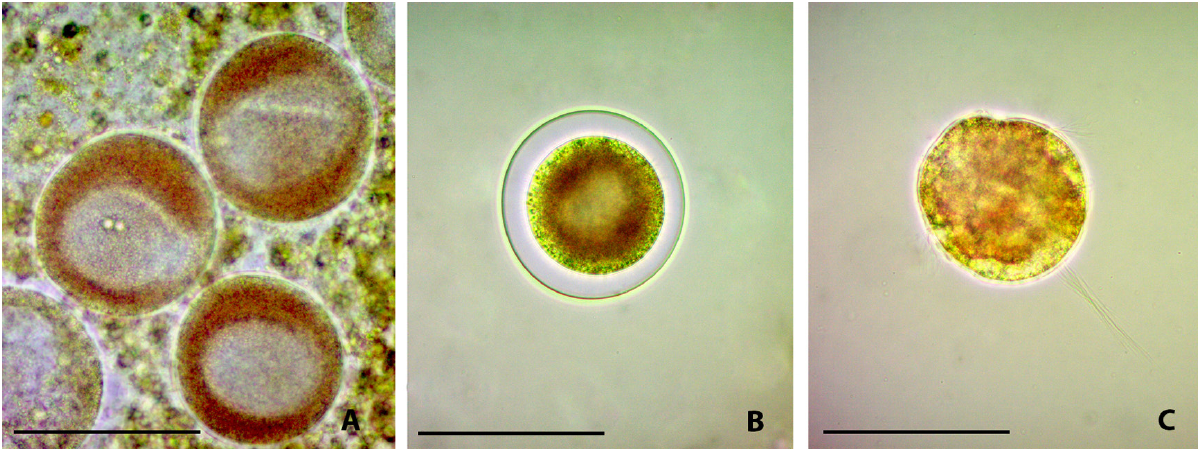
Fig. 5. – Sabellaria spinulosa. A, intracoelomic ocyte; B, fertilized egg; C, 48-hour trochophore. Scale bar 100 m